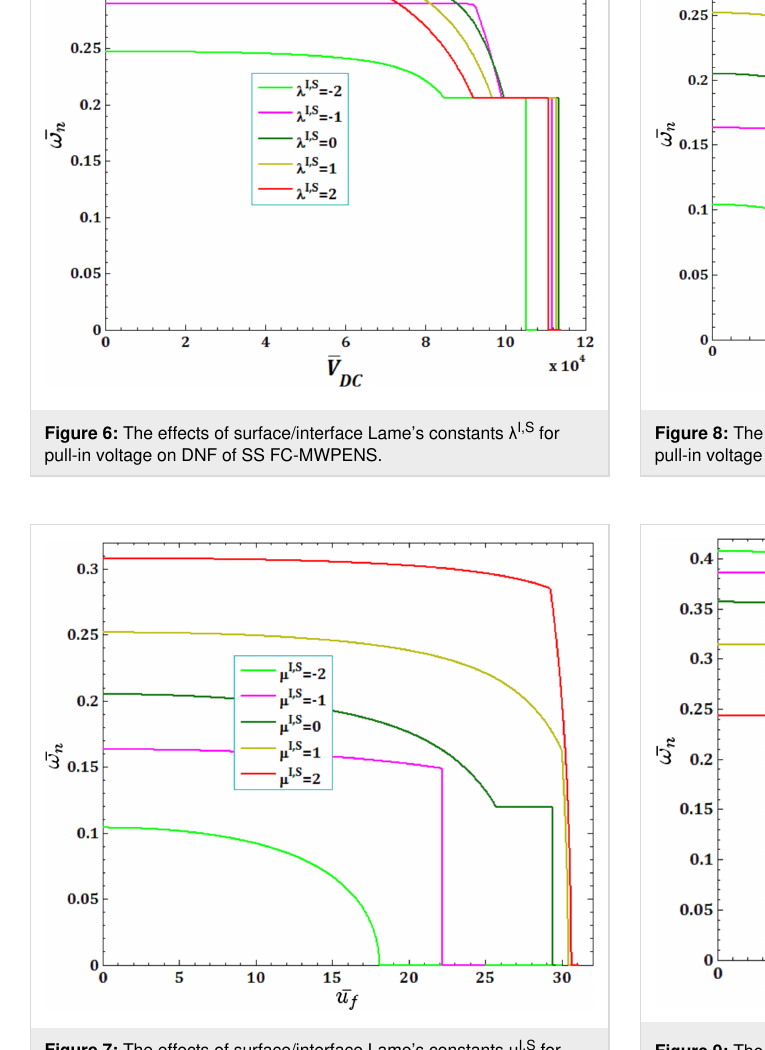
Figure 9: The effects of surface/interface residual stress for fluid velocity on DNF of SS